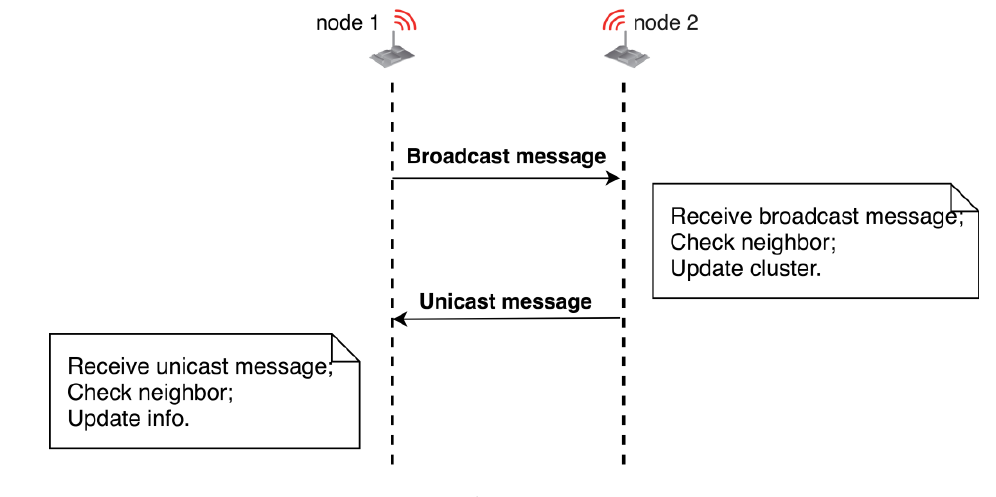
Figure 8. Clustering sequence. Algorithm 4 . Broadcast message initiation process for clustering phase (pseudo-code).